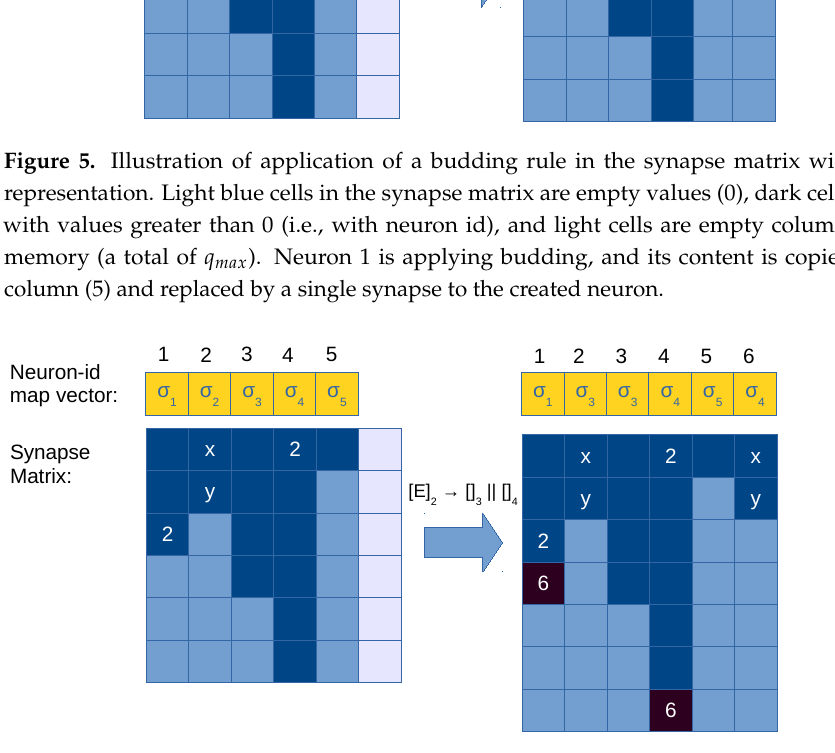
Figure 6. Illustration of application of a division rule in the synapse matrix with compressed representation. Light blue cells in the synapse matrix are empty values (0), dark cells are positions with values greater than 0 (i.e., with neuron id), and light cells are empty columns allocated in memory (a total of q max ). Neuron 1 is being divided, and its content is copied to an empty column (5). Columns 0 and 3 represent neurons with a synapse to the neuron being divided (1), so we need to update them as well with the synapse to the created neuron (5). Neuron 3 has reached its limit of maximum out degree, therefore we need to expand the matrix with a new row, or use a COO-like system to store these exceeded